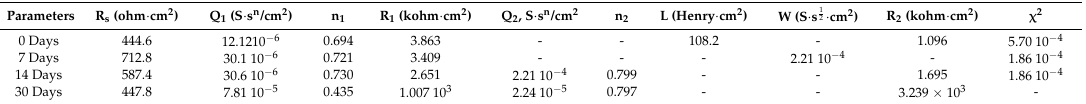
Table 4. Equivalent circuit parameters describing the electrochemical impedance spectroscopy (EIS) behavior of the 0, 7, 14, and 30 days